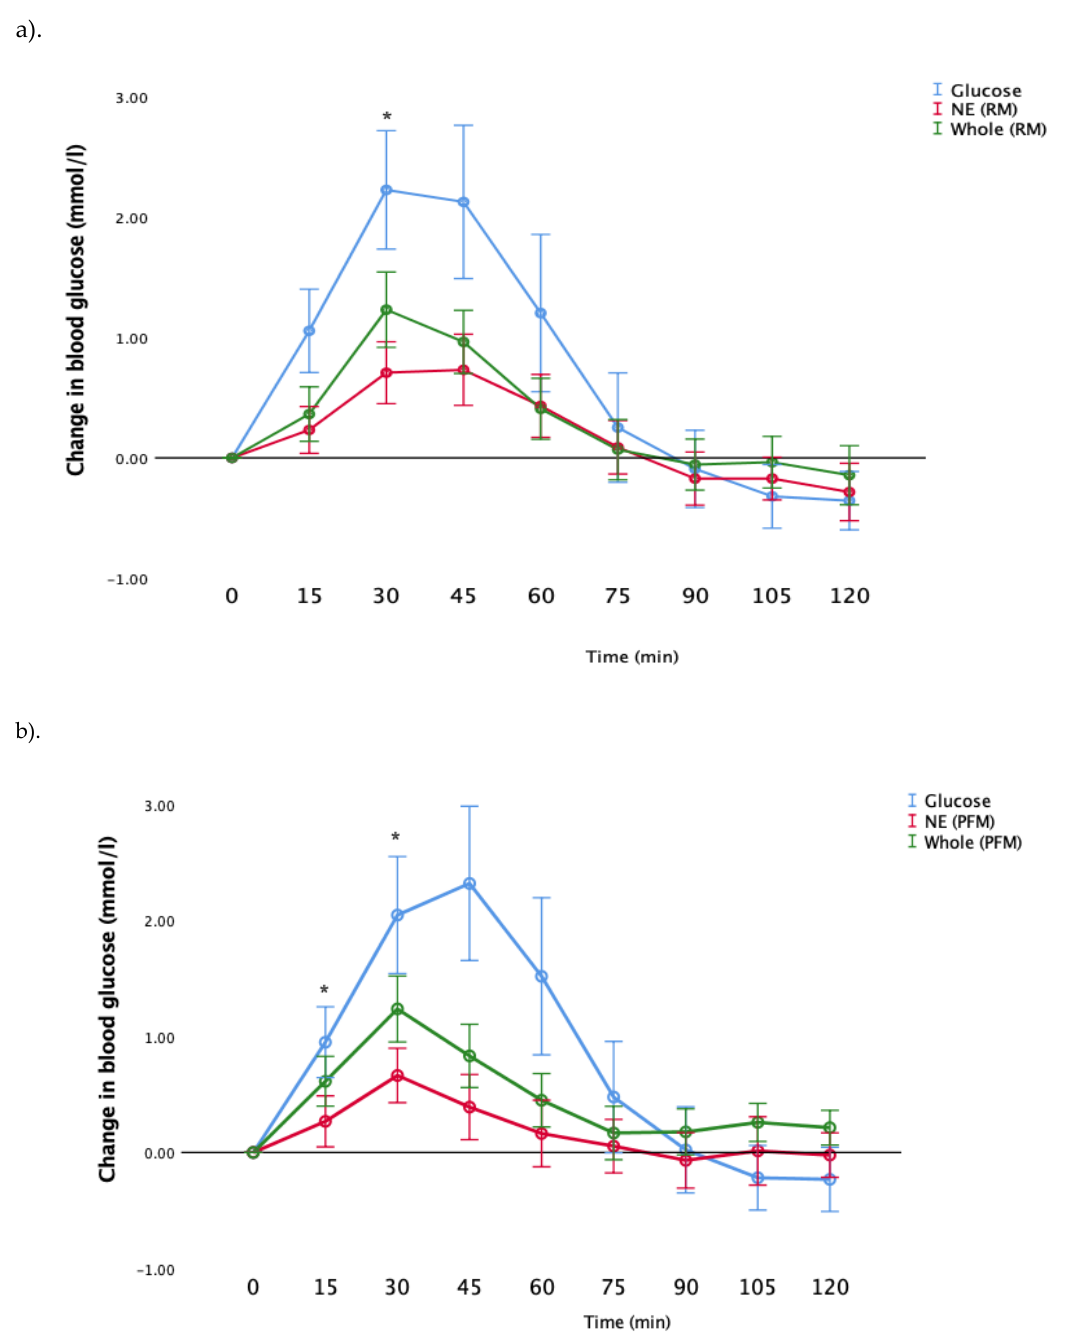
Figure 3. Comparison of incremental area under the curve values of blood glucose level after ingestion of the glucose control, whole and nutrient extracted (NE) fruit; ( a ) raspberry-mango arm; ( b ) passionfruit-mango arm. * LSD post hoc test indicates significant di ff erent between NE fruit and the whole p <